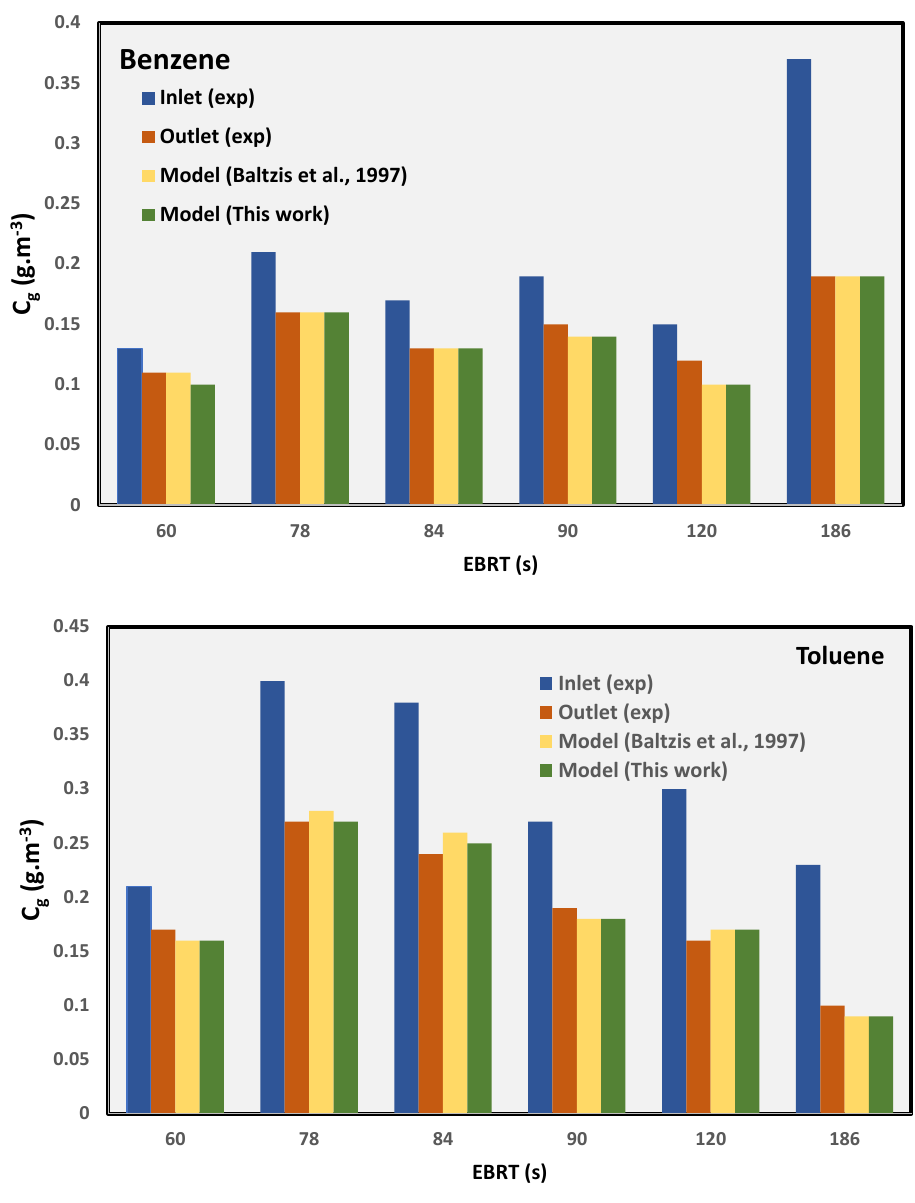
Figure 4. Comparison of model-predicted data against the experimental values [6] .